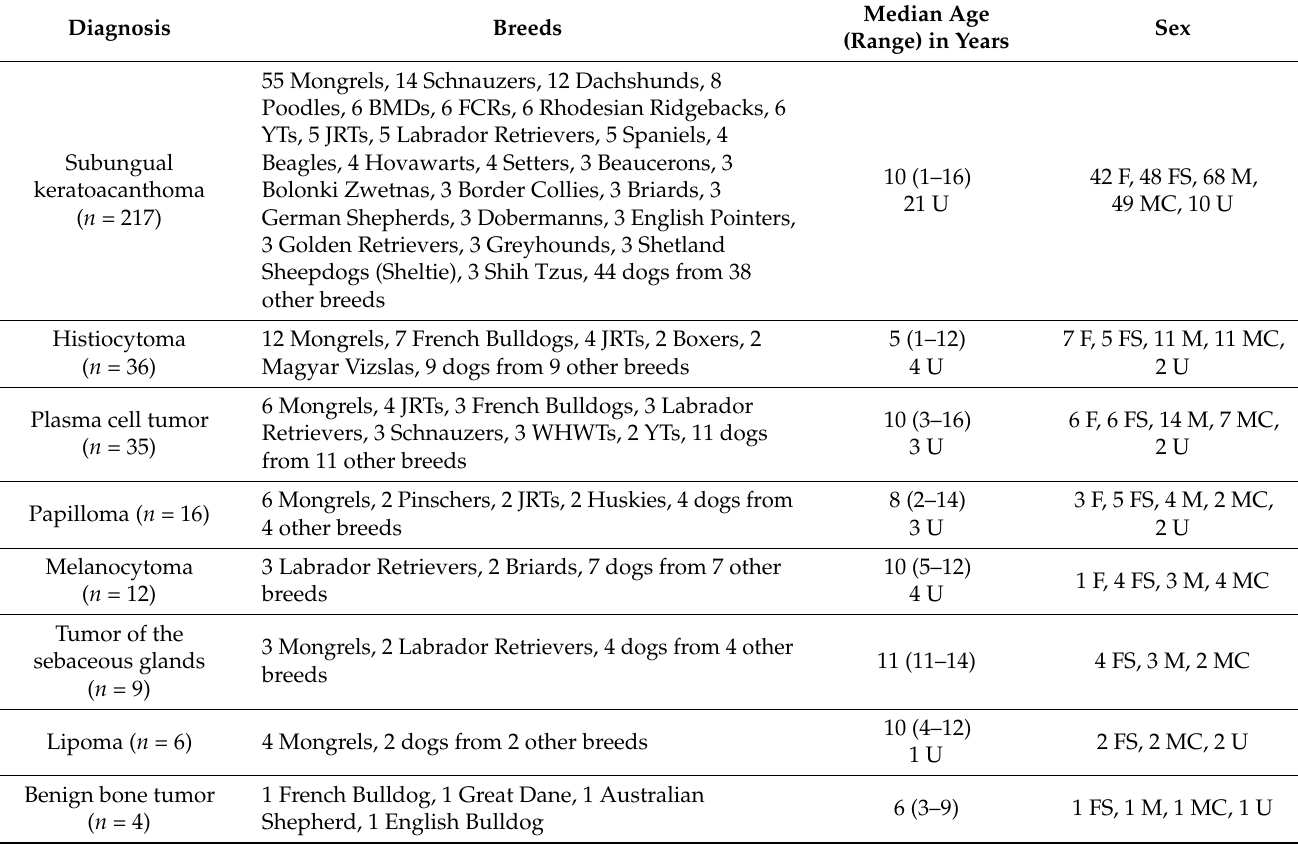
Table 3. Signalment of the 335 dogs with benign tumors (group